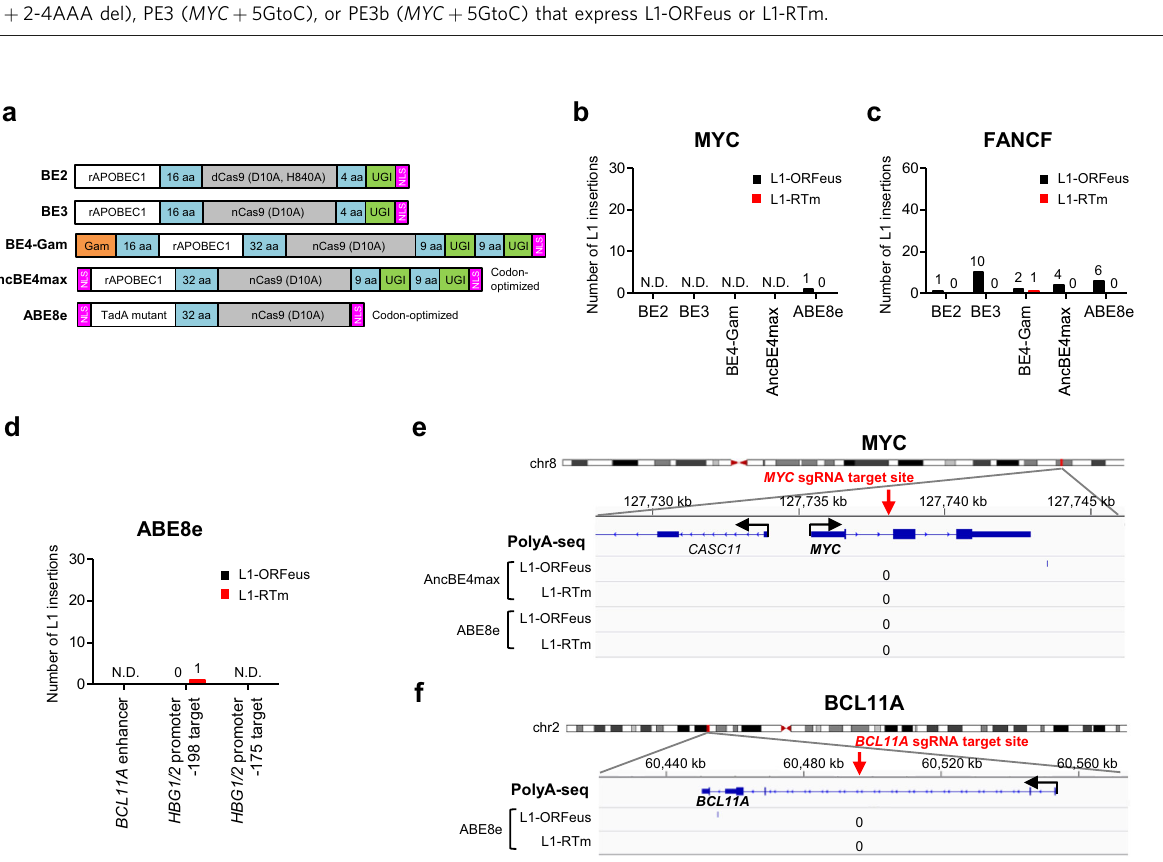
Fig. 7 Safety evaluation of prime editors in HEK293T cells. a Example diagram of the PE systems editing MYC + 5GtoC. While nCas9 (H840A) and pegRNA are required for all prime editing strategies, PE3 contains a nicking sgRNA at + 42 bp from the pegRNA-mediated nick to increase the editing ef fi ciency. PE3b contains a sgRNA ( − 5 bp from the pegRNA-mediated nick) with spacer that match the edited strand to minimize the presence of concurrent nicks. Nick only for PE3 introduces a single-strand break in the non-edited strand by a nicking sgRNA. b Numbers of L1-ORFeus insertions obtained by amplicon sequencing at the MYC locus targeted by PE2 ( MYC + 2-4AAA del), PE3 ( MYC + 2-4AAA del), or nick only for PE3 in HEK293T cells expressing L1-ORFeus, L1-ENm, L1-RTm, or GFP control. Number of L1-ORFeus insertions was pooled from three independent experiments with similar results. c Numbers of L1-ORFeus insertions obtained by amplicon sequencing at the MYC locus targeted by PE2 ( MYC + 5GtoC), PE3 ( MYC + 5GtoC), PE3b ( MYC + 5GtoC), or nick only for PE3/PE3b in HEK293T cells expressing L1-ORFeus or L1-RTm. d Numbers and fragment lengths of L1-ORFeus